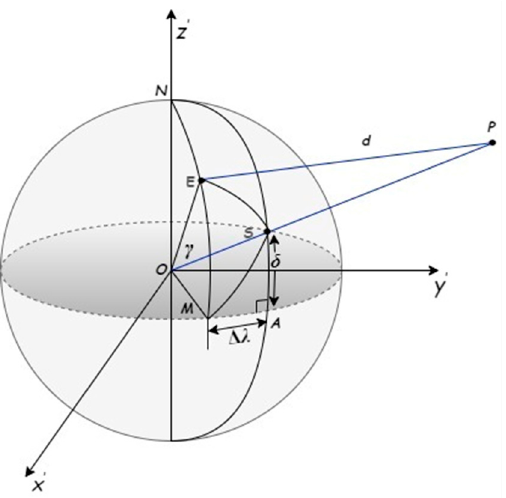
point S is shown in Figure 3.